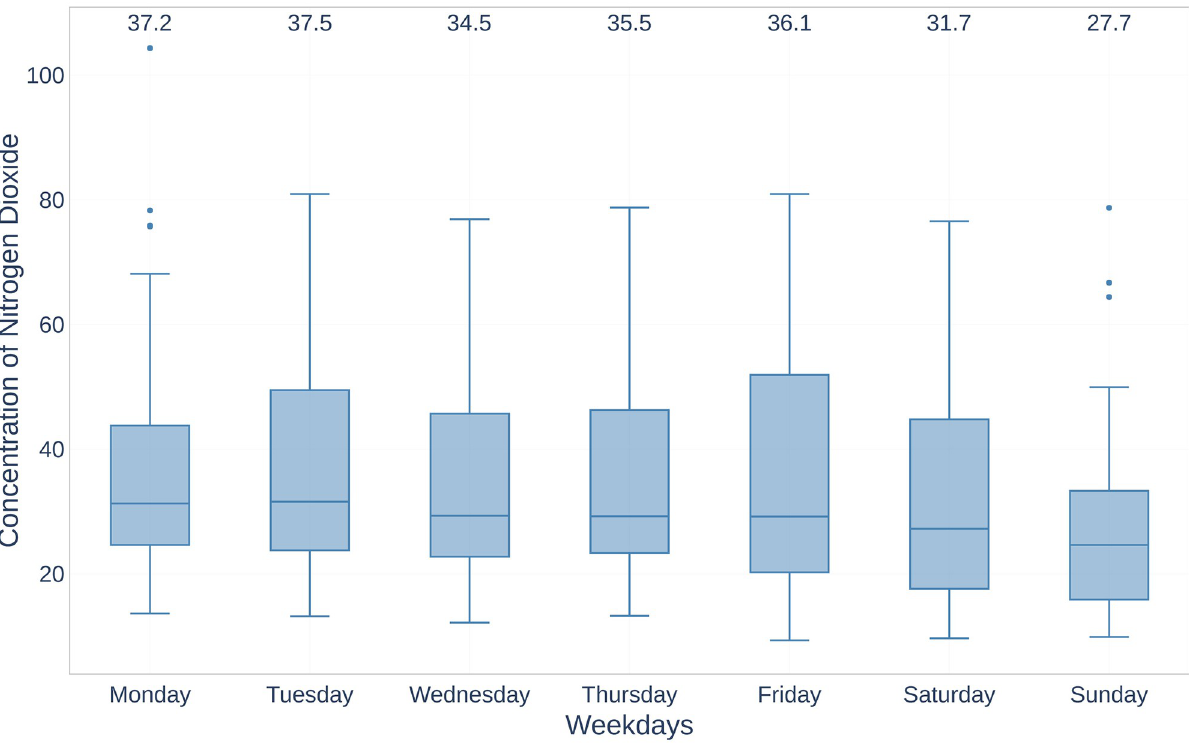
Fig 4. The concentration of NO 2 in weekdays dimension for the period January-June